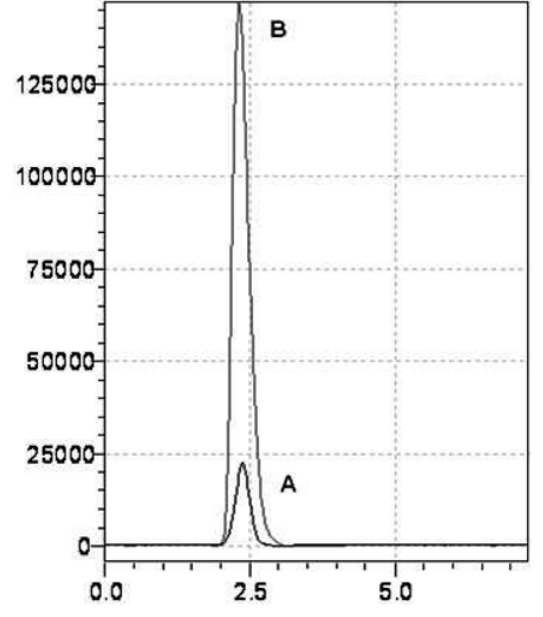
Figure 5. Ion chromatogram for A-Baltic (B3) and B-Romanite (R4) amber